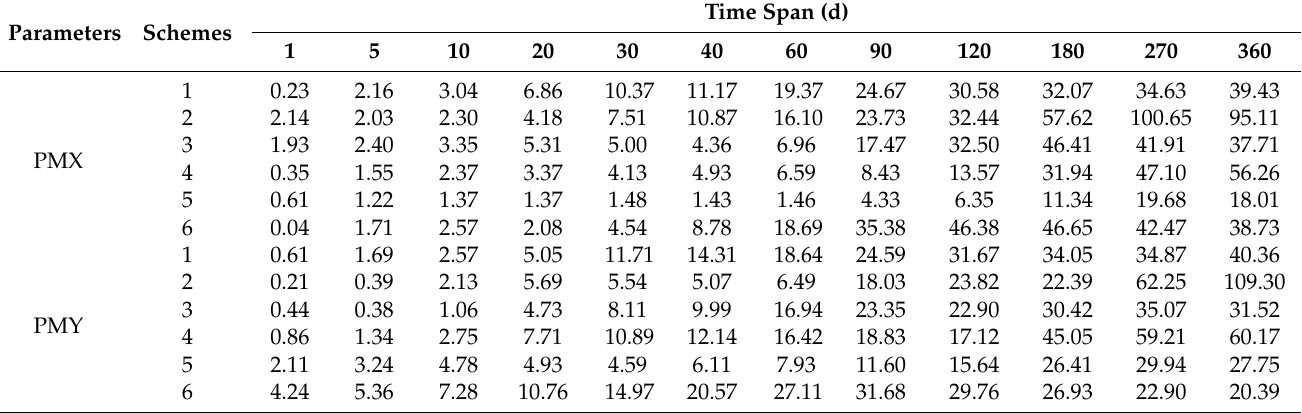
Figure 6. Comparison of polar motion prediction in different base time series based on hybrid CNN–LSTM model. True value was provided by Bulletin A. In graphs, 6y–12y indicate predicted values for different base time series and VLBI-10y is the VLBI observations estimated in this paper. Table 5. Accuracy statistics of different prediction schemes (RMSE (mas)). Scheme 1 is a 6-year base time series prediction based on LS + AR model, Schemes 2–5 are base time series prediction based on hybrid CNN–LSTM model, and Scheme 6 is prediction of estimated polar motion from 2011 to 2020 VLBI observations based on hybrid CNN–LSTM